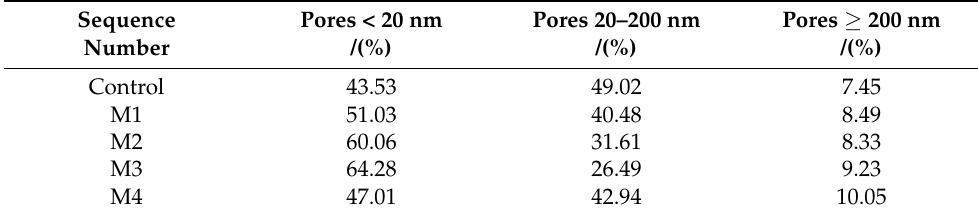
Table 3. Pores size distribution of